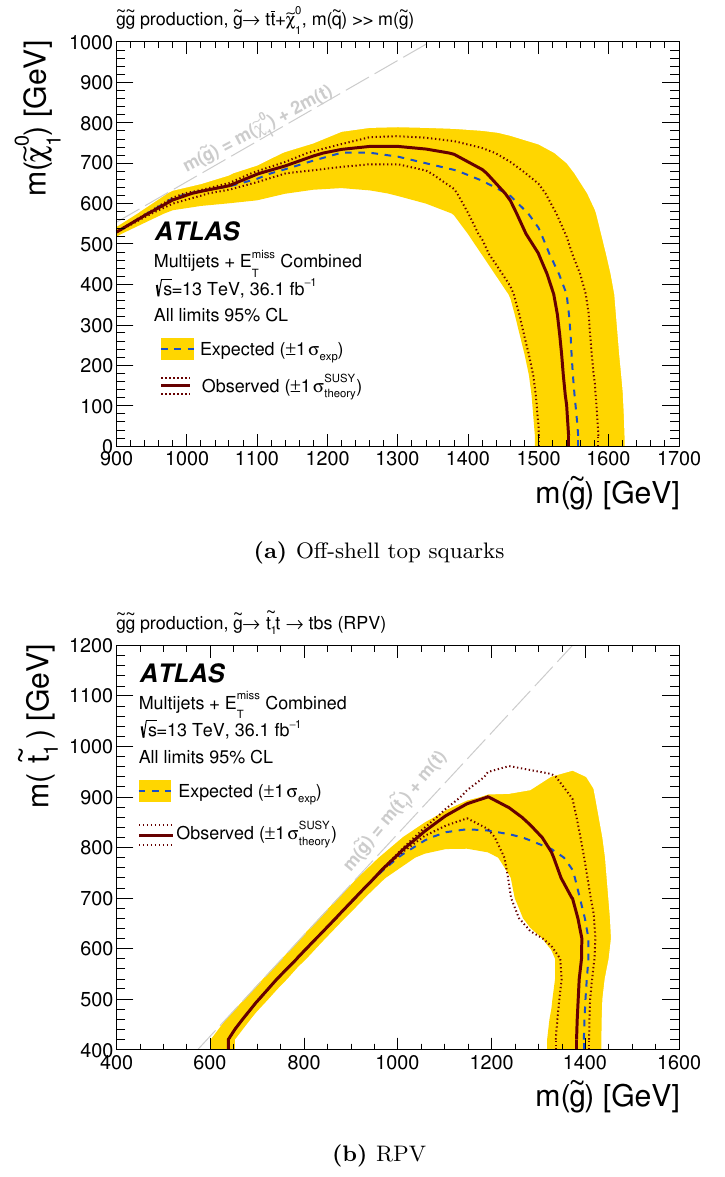
Figure 7. Exclusion contours in gluino-mediated top squark production scenarios, illustrated in the m ~ g ; m plane with o(cid:11)-shell squarks (a) and an R -parity-violating scenario plane in which the ~ (cid:31) 0 1 top squark decays via ~ t 1 ! sb (b), shown in the m ~ g ; m ~ plane. The solid maroon line indicates the t 1 observed limit, while the dashed blue line shows the expected limit. Experimental, MC theoretical and statistical uncertainties are shown in the yellow band. Dotted maroon lines delimit the variation of the observed limit within the (cid:6) 1 (cid:27) uncertainties in the signal cross-section at NLO+NLL accuracy.